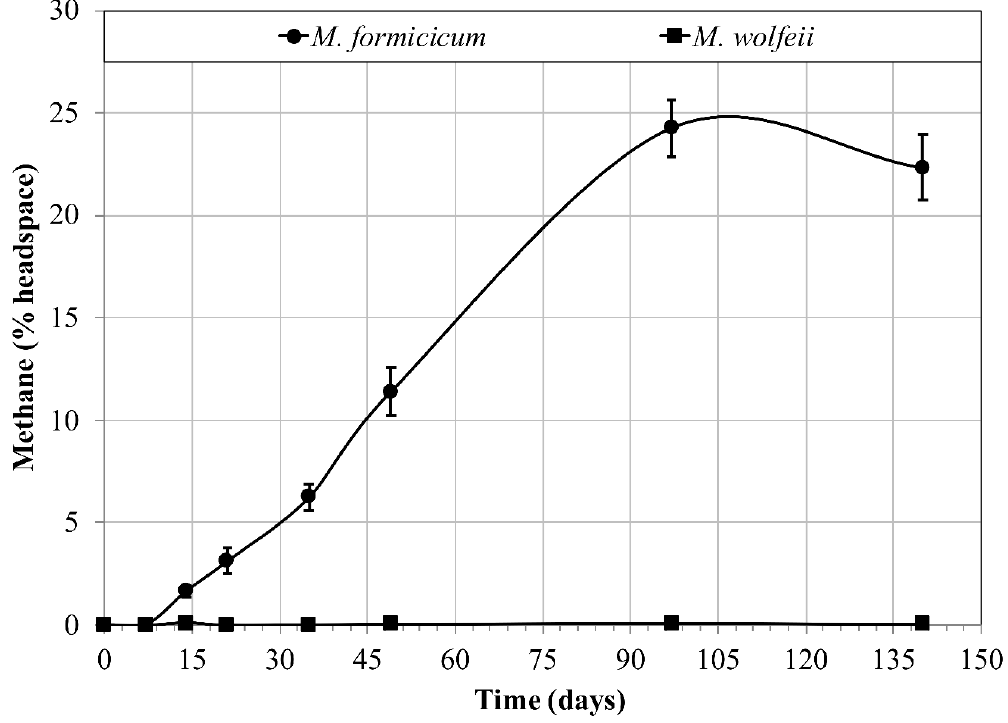
Figure 1. Methane production (% headspace) over time for two species of methanogens ( Methanobacterium formicicum , Methanothermobacter wolfeii ) at 22 °C. Error bars indicate ± one standard deviation ( n =